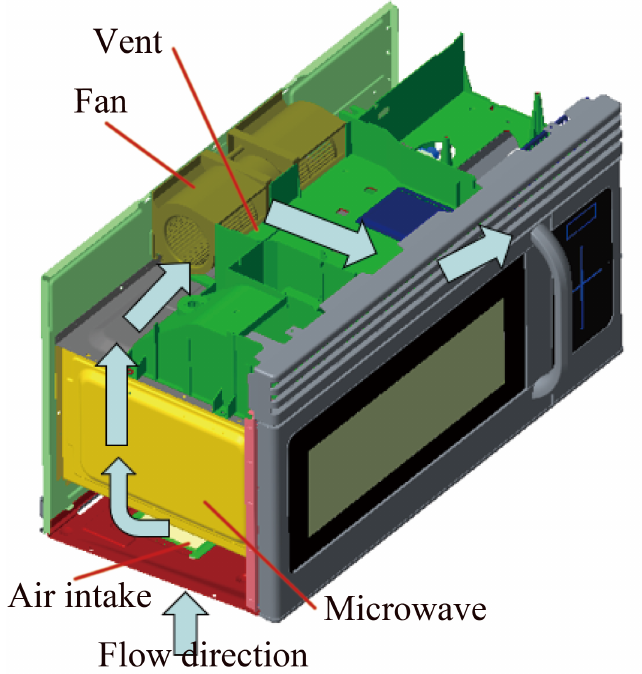
Figure 2. Internal structure and flow path in the OTR microwave.